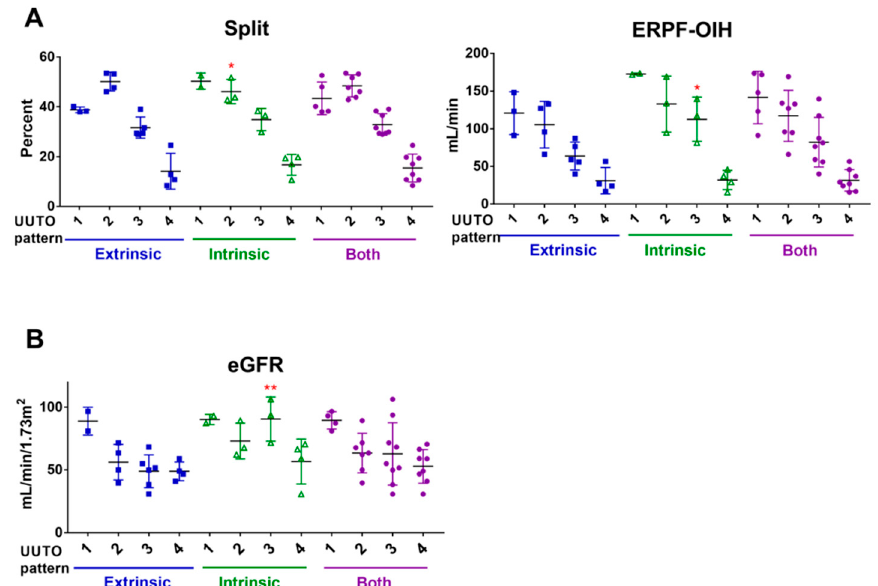
Figure 1. Renal functions according to UUTO patterns in the hydronephrosis group. The split and normalized ERPF-OIH in the affected kidney in the 99mTc-MAG3 renal scan ( A ) and eGFR ( B ) according to upper urinary tract obstruction (UUTO) patterns in extrinsic (blue squares), intrinsic (green triangles), and all UUTO (purple circles) cases. Generally, these parameters decreased with an increasing UUTO pattern. * p < 0.05, ** p < 0.01 vs. extrinsic UUTO by two-way analysis of variance (ANOVA) with Sidak’s multiple comparisons test.